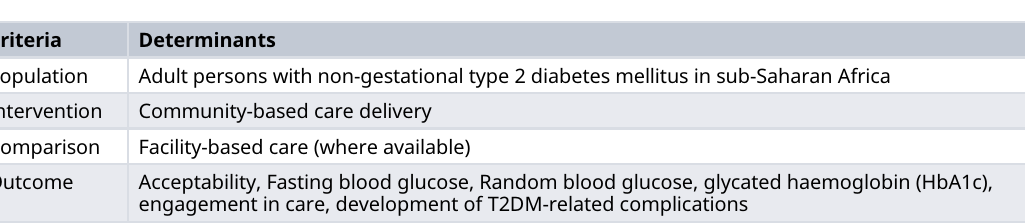
Table 1. The PICO